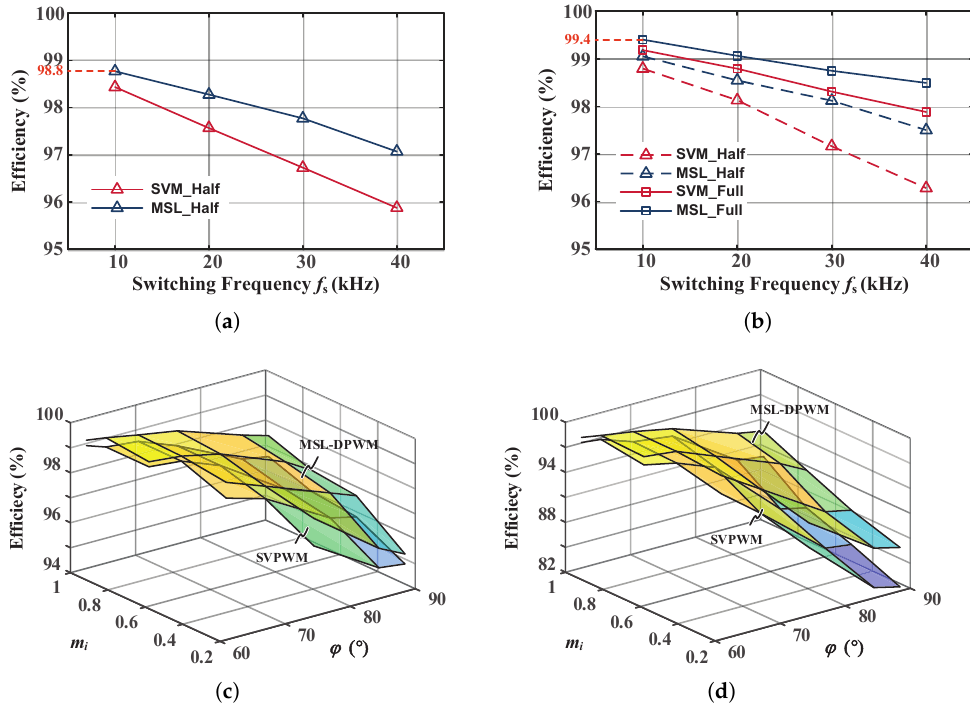
Figure 13. Comparison of the measured efficiency: ( a ) at f o = 25 Hz with half load, ( b ) at f o = 50 Hz with half and full load, ( c ) a 3D plot of the efficiency with various modulation indices and the power factor at f s = 10 kHz, and ( d ) a 3D plot of the efficiency with various modulation indices and the power factor at f s = 40